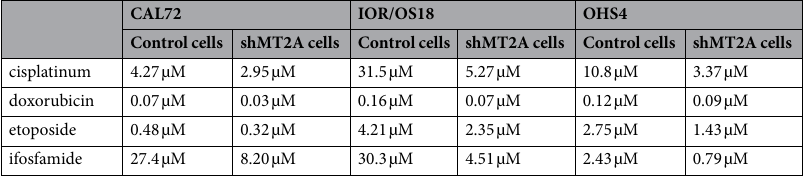
Table 1. Half maximal inhibitory concentrations (IC50) for chemotherapy. Cell viability was assessed in human CAL72, IOR/OS18 and OHS4 cell lines incubated for 72 hrs in the presence of increasing doses of each indicated drug.